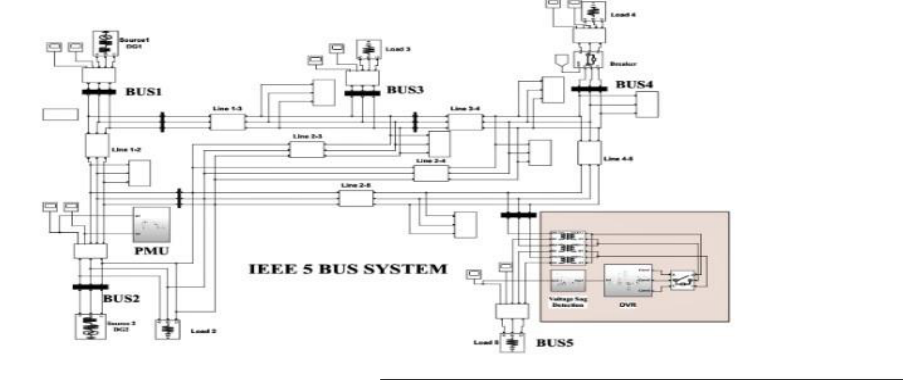
Fig12 IEEE 5 Bus System in MATLAB/Simulink DVR is connected between BUS 4 and BUS 5.